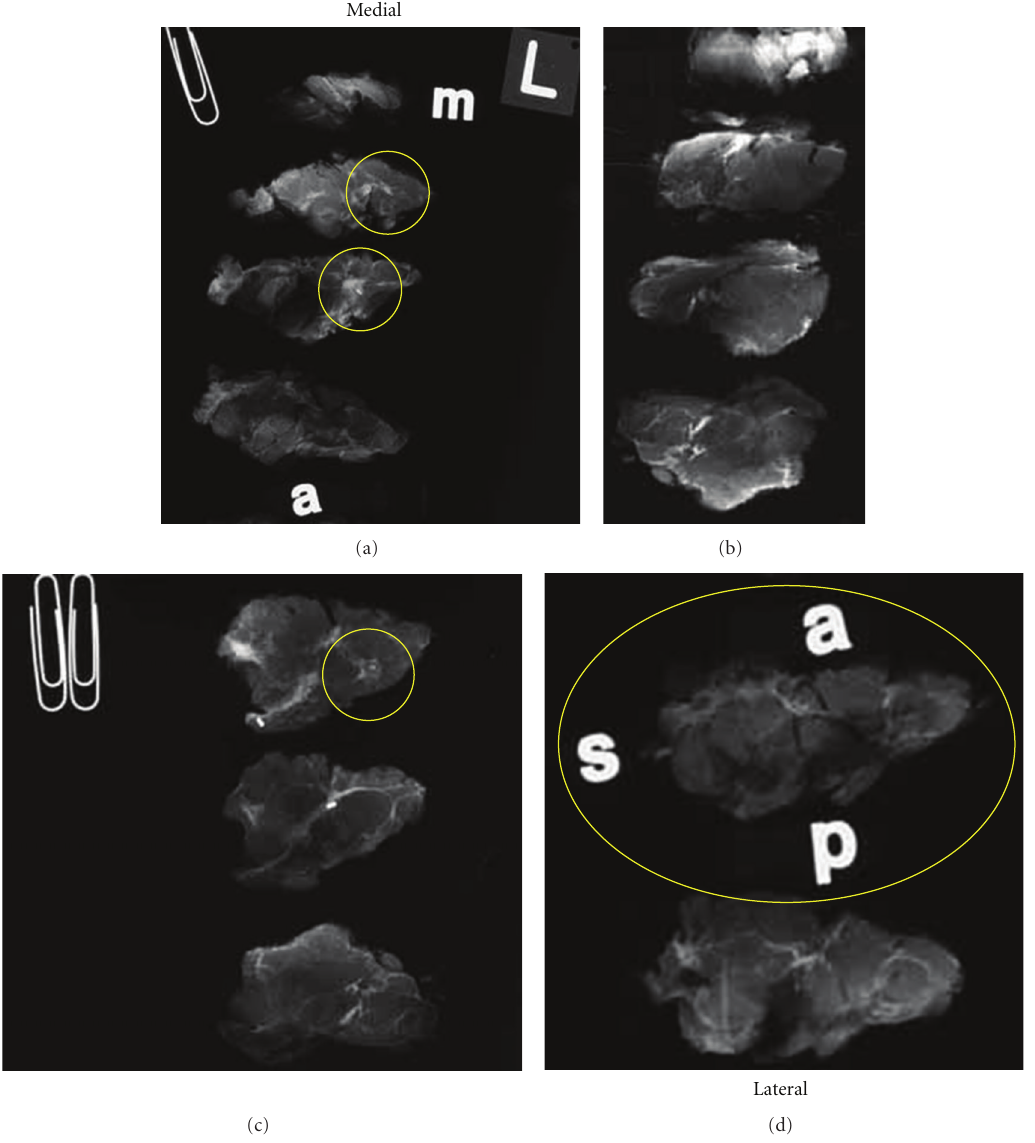
Figure 1: Specimen radiographs of a lumpectomy from a left breast sectioned at 5mm intervals in the sagittal plane. Sections are sequentially oriented from medial (a) to lateral (d). Yellow circles correspond to marks made by a breast imager following review and correlation of relevant imaging studies to denote significant radiographic findings such as calcification, mass density, architectural distortion, ultrasound findings and enhancement on MRI. The imager selectively marks sections to demonstrate maximum size and extent of neoplasia and close proximity to margins with the expectation that the pathologist will provide histopathologic correlation of identified imaging